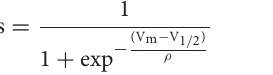
where E Ca = 120 mV and g